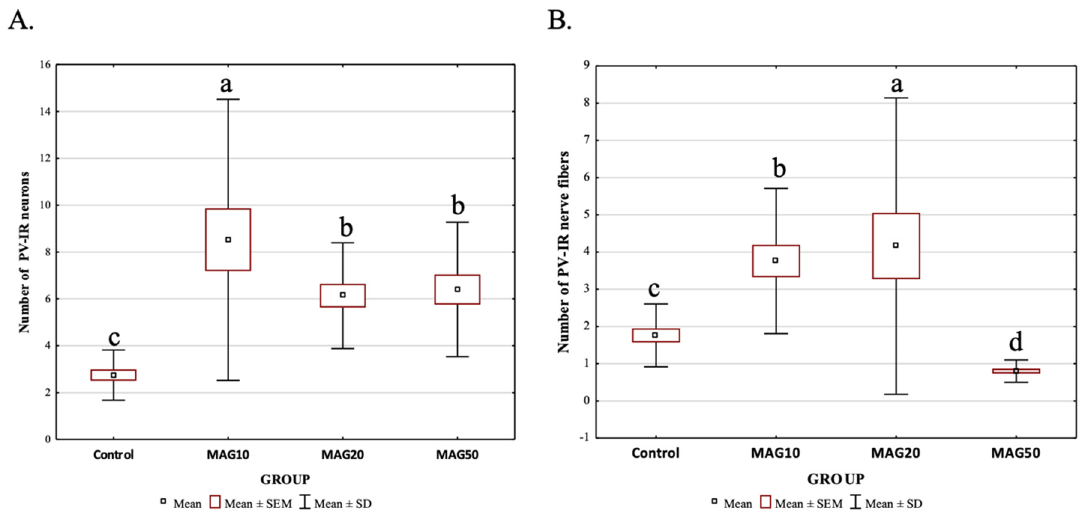
Figure 7. Differences in the average number of PV-IR neurons ( A ) and PV-IR nerve fibers ( B ) depending on the dose of magnoflorine (irrespective of the hippocampus field). The data are expressed as means ± SEM (standard error of the mean; box) and standard deviation (whiskers); a–d—different letters indicate significant differences between the experimental groups at p ≤ 0.0001; n = 5.